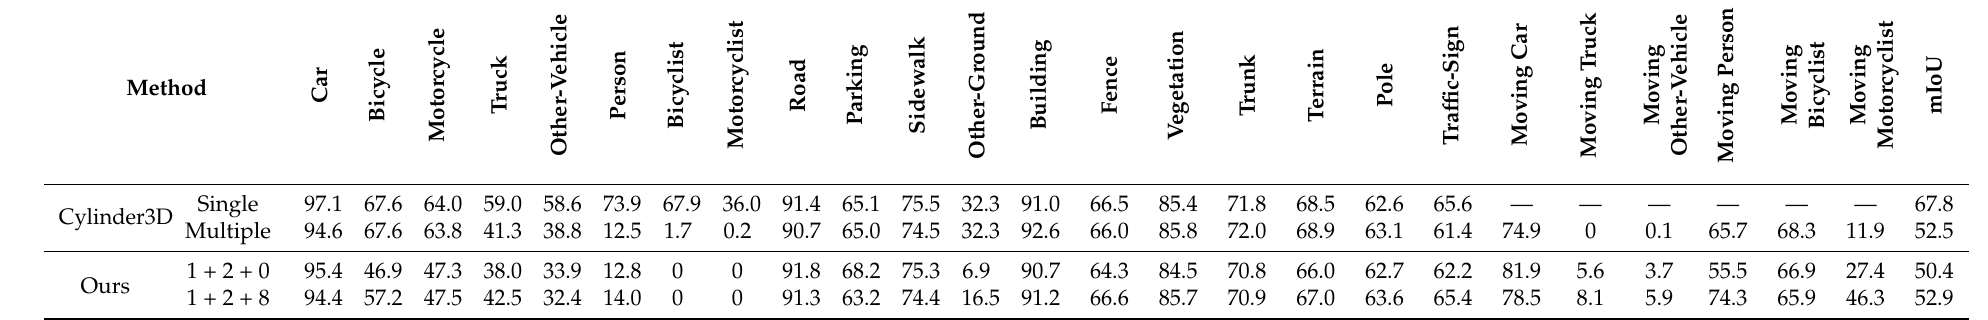
Table 6. Comparison of LiDAR-based moving object semantic segmentation performance on the test split of SemanticKITTI. Metrics are provided in [%].